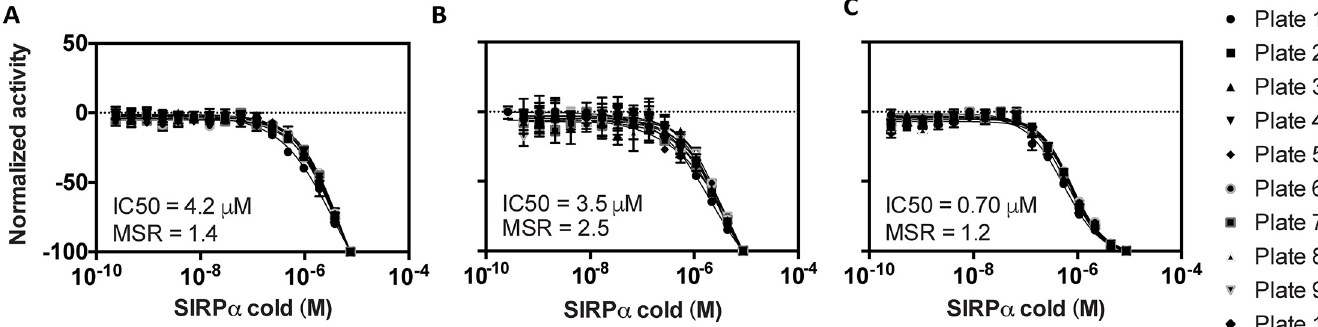
Fig 7. Control inhibitor performance in pilot screening. Results for the (A) CisBio, (B) LANCE, and (C) AlphaScreen assays shown. SIRP α -cold was titrated as a control inhibitor in each assay (n = 2). Error bars represent the standard deviation of two replicates. The average IC 50 and minimum significant ratio (MSR) was calculated over the 10-plate run for each screening assay. MSR is defined as the smallest ratio between the potencies of two compounds that is statistically significant and p 2s is calculated as MSR = 10 2 , where s is an estimate of the standard deviation of a log potency for one compound.